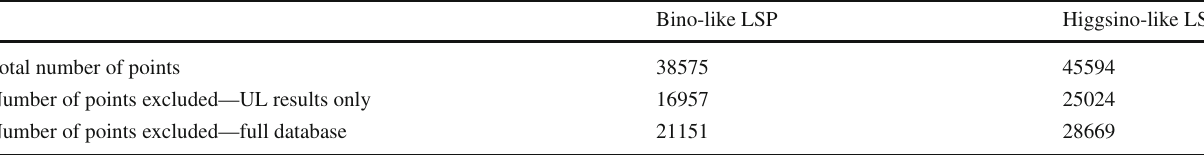
Table4 Summaryofresults,listingthenumberofATLAS-excludedpMSSMpointstestedinthisstudy,thenumberofpointsexcludedby SModelS when using UL-type results only, and the number of points excluded when using the full 8 TeV database including EM-type